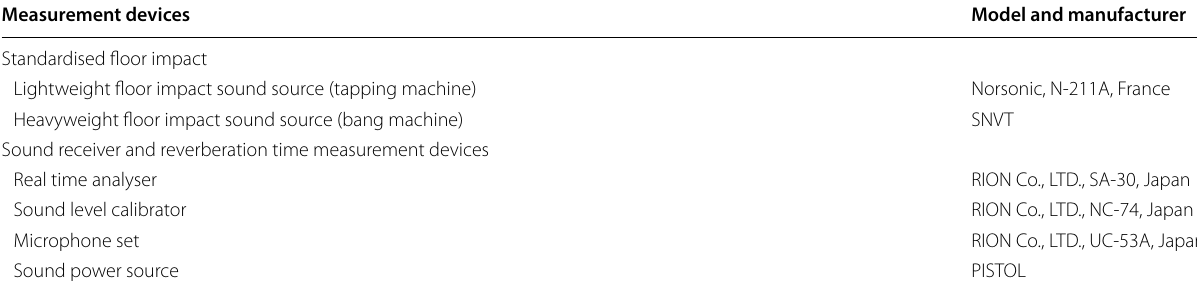
Table 1 Devices of the floor impact sound